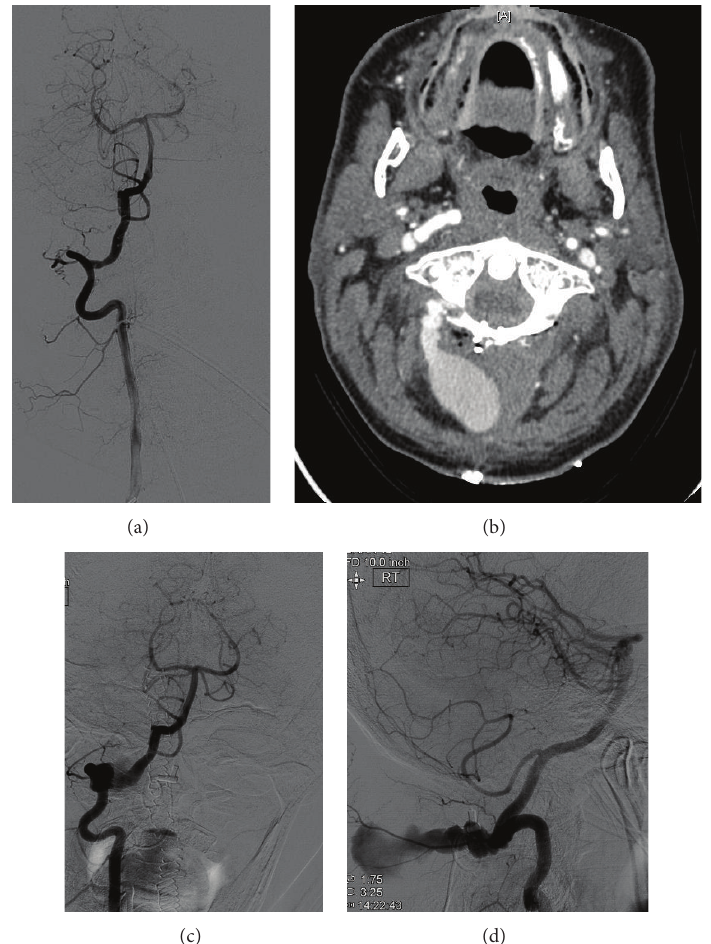
Figure 1: (a) shows normal filling of the right vertebral artery immediately following intraoperative injury: a small irregularity in the wall can be seen. (b) (CT angiogram) and (c) and (d) (digital subtraction angiogram) show a large saccular pseudoaneurysm arising from the V3 segment of the vertebral artery. The imaging was performed on the third postoperative